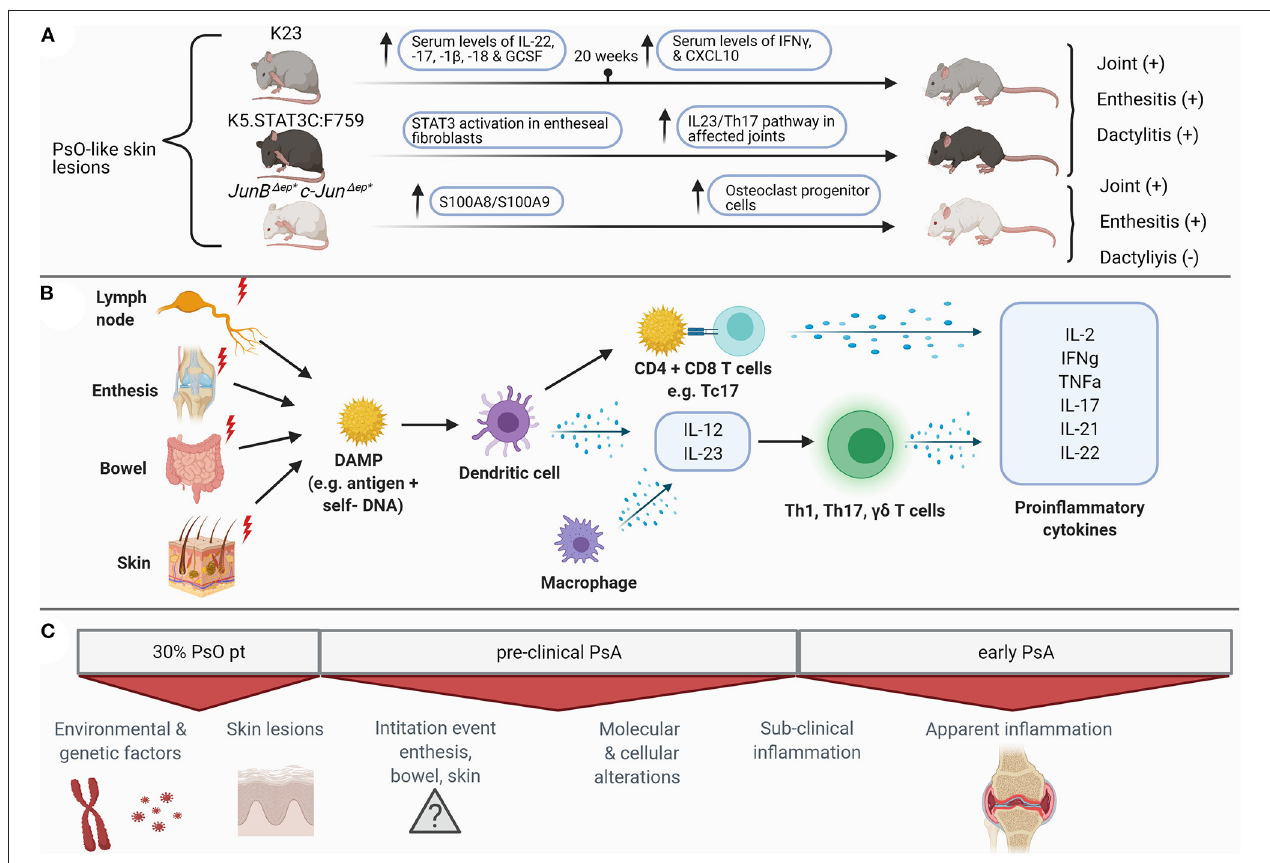
FIGURE 1 | Schematic overview of preclinical and clinical molecular (B) and clinical alterations (C) in psoriatic arthritis in humans and the featured mice models (A) for psoriatic arthritis. PsO, psoriasis; IL, interleukin; IFN, interferon; GCSF, granulocyte colony-stimulating factor; CXCL, chemokine ligand; STAT, signal transducer and activator of transcription; Th, T helper cells; DAMP, danger associated molecular patterns; CD, cluster of differentiation; Tc, cytotoxic T cells; TNF, tumor necrosis factor; PsA, psoriatic arthritis. Figure created with